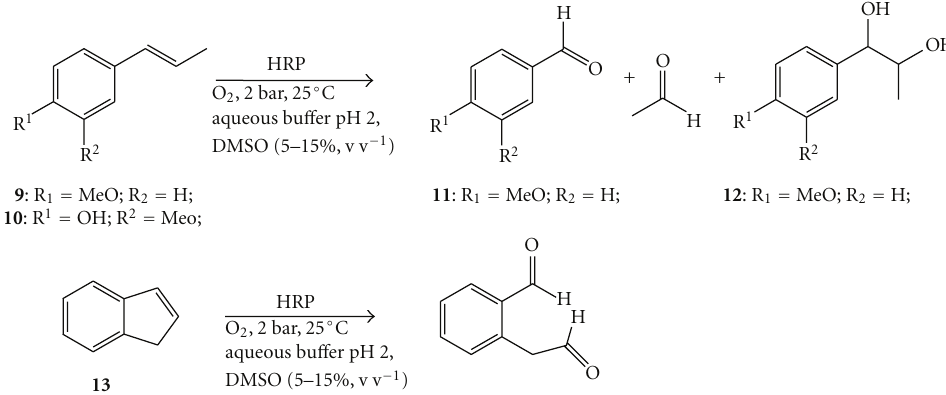
Scheme 5: Alkene cleavage of trans -anethole ( 9 ), isoeugenol ( 10 ), and indene ( 13 ) catalysed by HRP at 2-bar dioxygen pressure and ambient